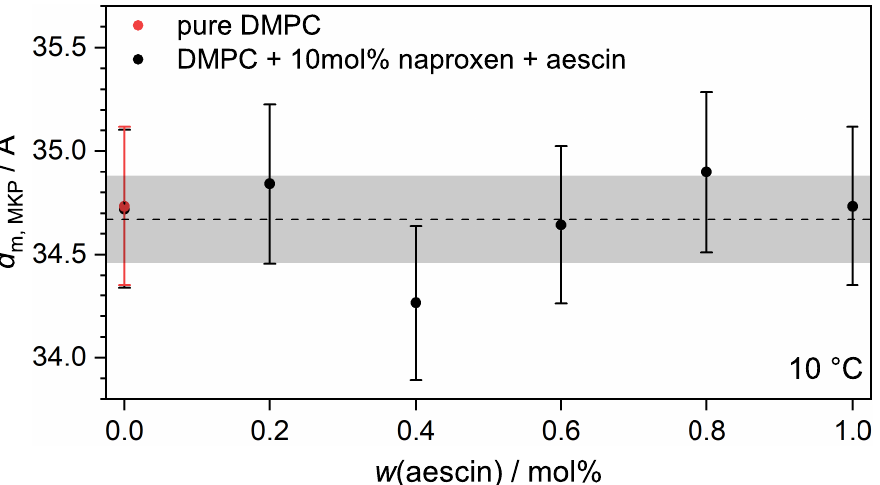
Figure 8. Membrane thicknesses d m,MKP of vesicles determined via MKP approximation at T = 10 °C in dependence of w (aescin). The dashed line gives the mean value of d m,MKP at ( 34.67 ± 0.21 ) Å. The red circle depicts the membrane thickness of pure DMPC